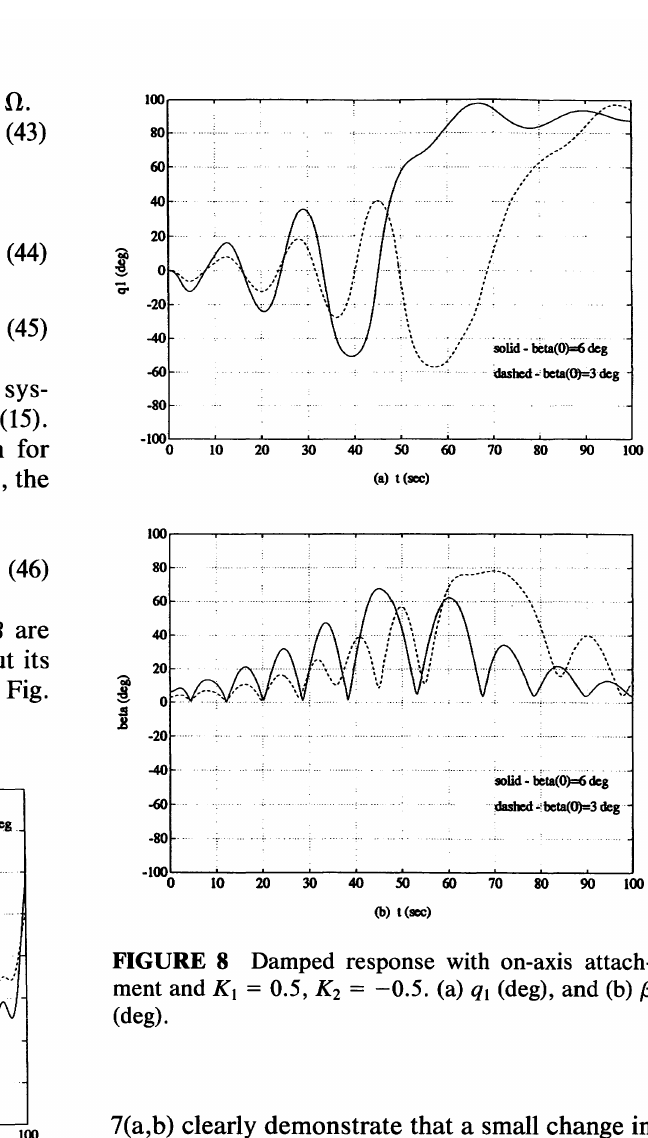
FIGURE 8 Damped response with on-axis attach ment and K, = 0.5, K2 = -0.5. (a) q, (deg), and (b) f3